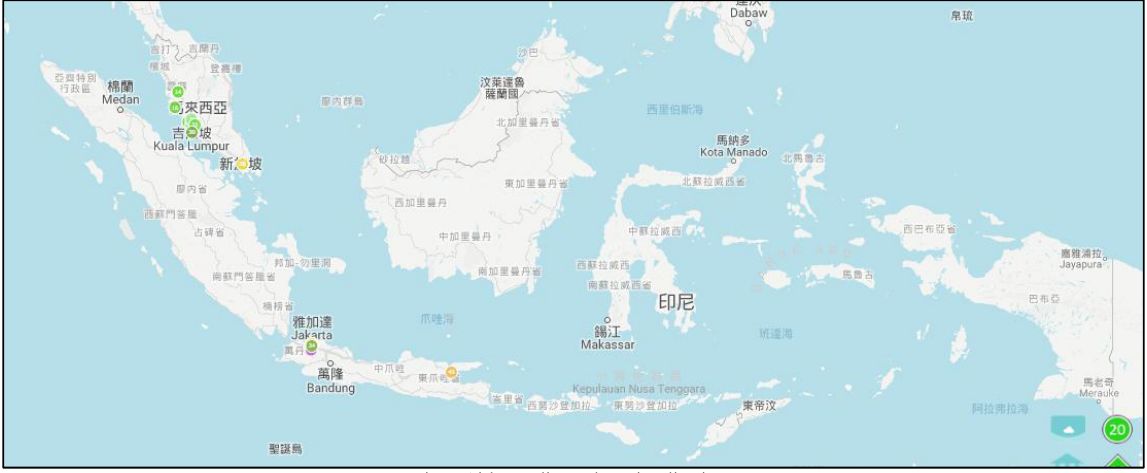
Fig. 5 Airbox Edimax data